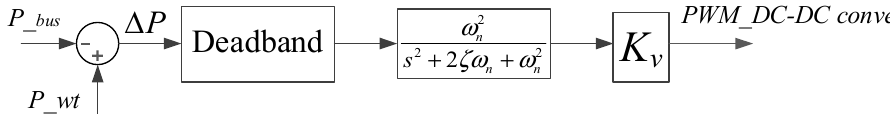
Figure 5. Block diagram of a VSP-based FAPR control strategy.